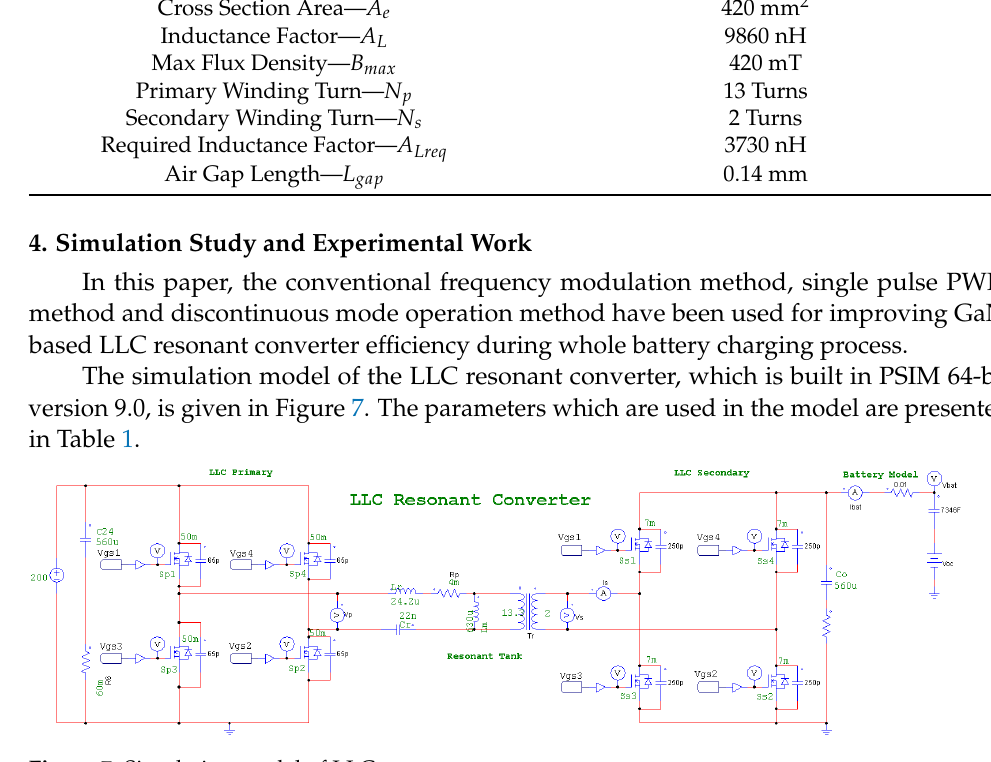
Figure 7. Simulation model of LLC resonant converter.